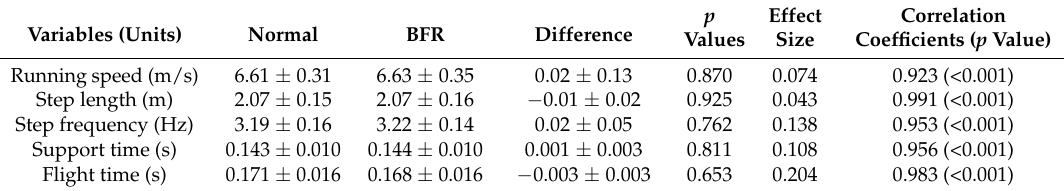
Table 1. Spatiotemporal variables and corresponding difference, p value of a t -test, effect size (Cohen’s d), and correlation coefficients between normal and blood flow restriction (BFR) conditions.